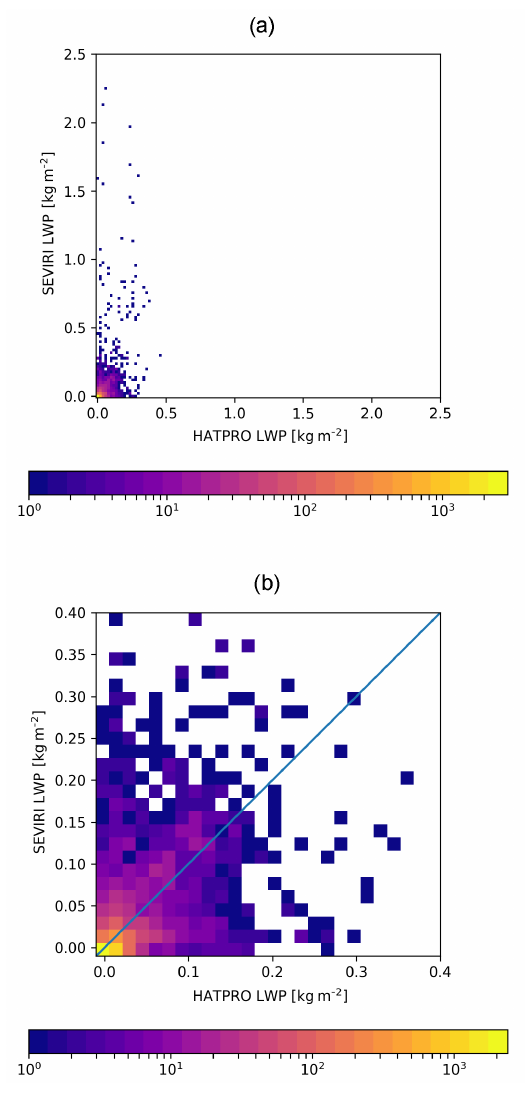
Figure 9. Comparison of the HATPRO and SEVIRI instanta- neous measurements by means of two-dimensional histogram with number-of-occurrence colour scale. (a) Extra high LWP values are shown. (b) Only LWP < 0.4kgm − 2 are